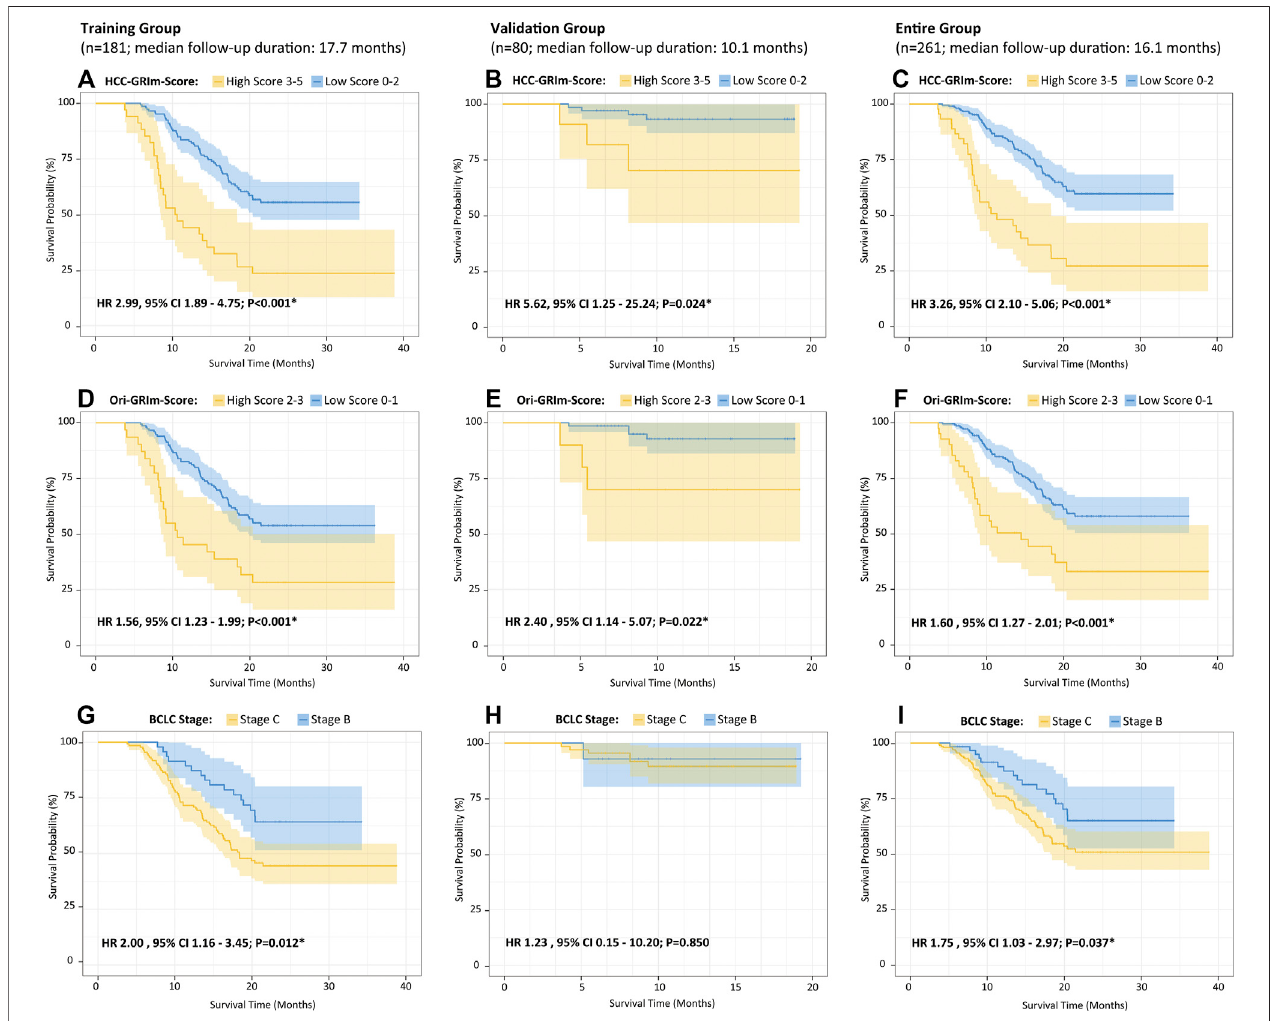
FIGURE 1 | Kaplan – Meier curves of the overall survival for HCC patients after ICIs therapies divided by HCC-GRIm-Score (A – C) , Ori-GRIm-Score (D – F) , and BCLCstagingsystem (G – I) intermsoftraininggroup,validategroup,andentiregroup,respectively.HCC,hepatocellularcarcinoma;ICIs,immunecheckpointinhibitors; BCLC, Barcelona clinic liver cancer stage; HR, hazard ratio; CI, con fi dence interval.